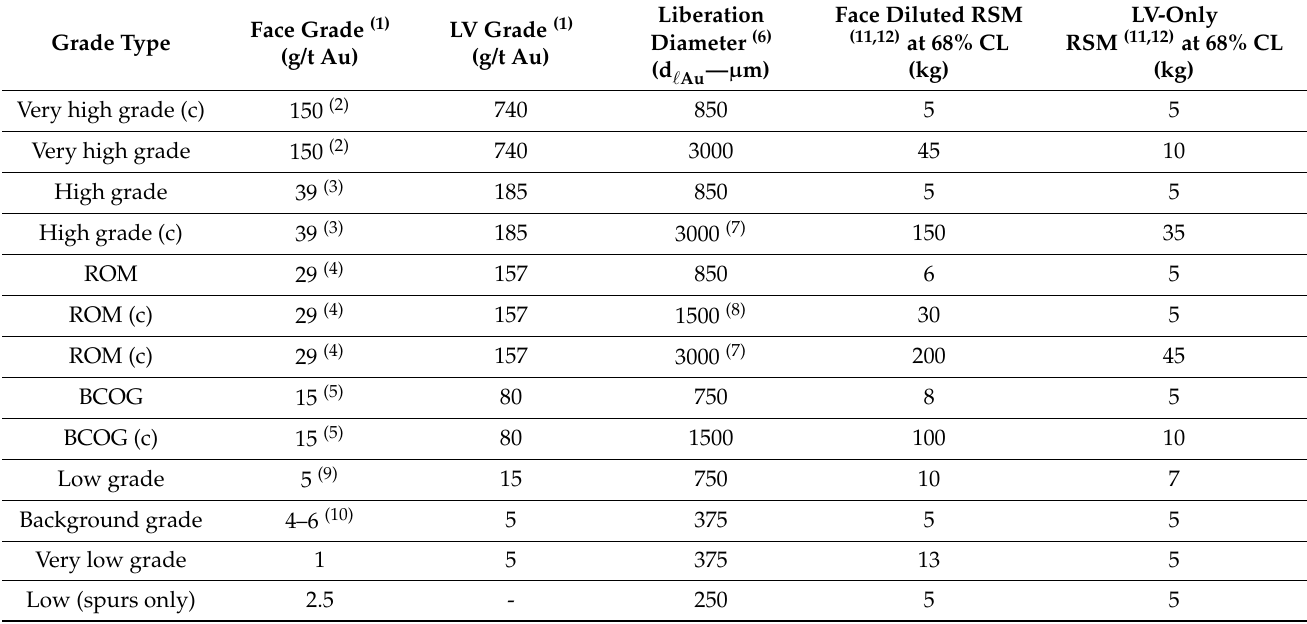
Table 16. Representative sample mass for diluted mine faces and LV- and spur-only required to achieve precision of ± 20% at the 68% confidence limits for different grade-liberation diameter scenarios. ROM: run of mine; BCOG: breakeven cut-off grade; CL: confidence limits; (c):